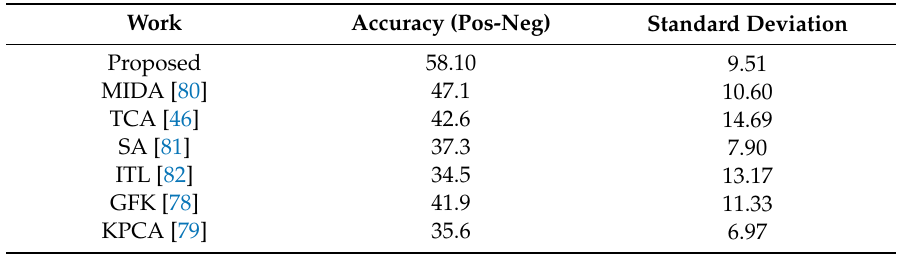
Table 9. One-subject-out cross-dataset prediction accuracy and standard deviation comparison of several studies (Trained on the SEED and tested on the DEAP).